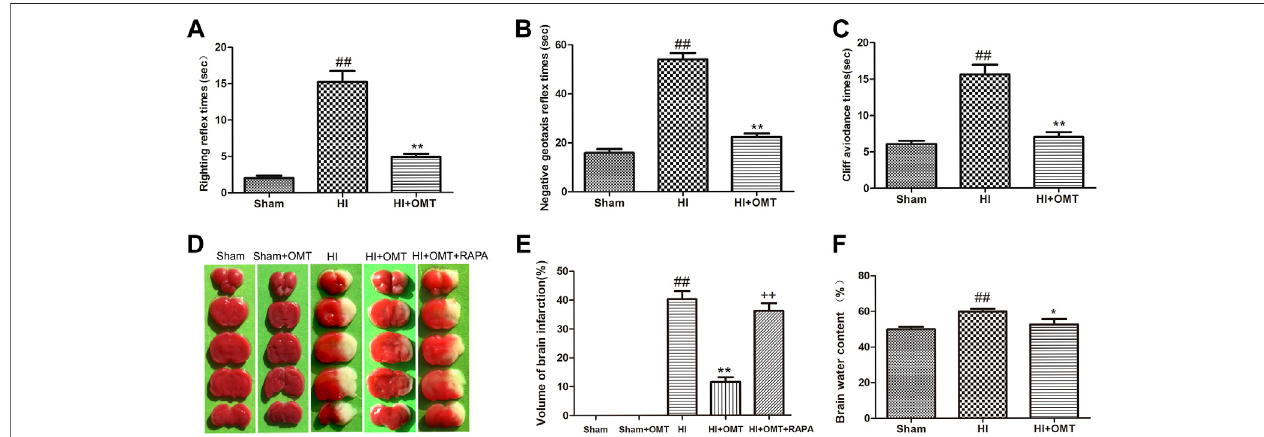
FIGURE1 | Changes in the early neurologicalre fl ex performances, infarct volume and water volumes in neonatalrats at 48 h after hypoxia-ischemia braindamage (HIBD). (A) The latency of righting re fl ex. (B) The latency of negative geotaxis re fl ex and (C) The latency of n Cliff avoidance re fl ex. D Representative photographs of the infarct volume identi fi ed with 2,3,5-triphenyltetrazoliuM chloride (TTC) staining. (E) Measured infarct volumes. (F) Assessments of brain water content. The results are expressedasmeans ± SEM( n (cid:1) 6pergroup). ## p < 0.01vs.theshamgroup;* p < 0.05,** p < 0.01vs.theHIgroup;and ++ p < 0.01vs.theoxymatrine(OMT)group.